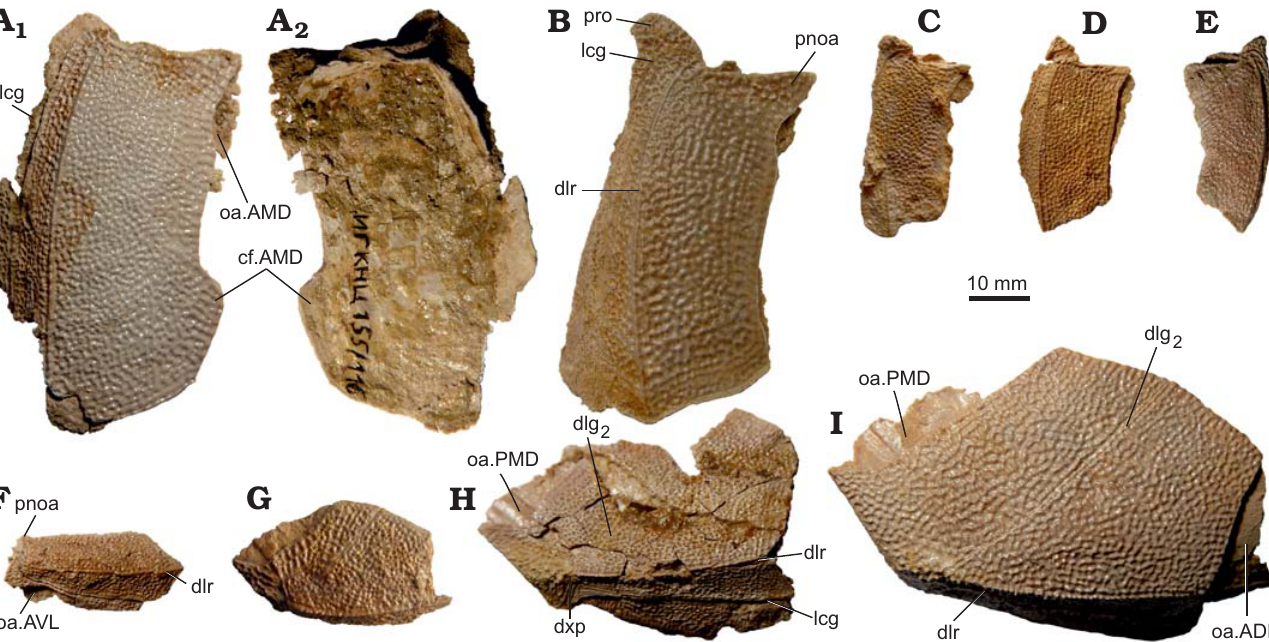
Fig. 10. Antiarchan fish Bothriolepis leptocheira jeremejevi (Rohon, 1900), Sosnogorsk locality, Sosnogorsk Formation, lowermost Famennian, anterior dorso-lateral (A–D, F, left; E, right) and left mixilateral (G–I, right) plates of the trunk armour. A . IG KSC 155/116 in dorsal (A 1 ) and visceral (A 2 ) views. B . IG KSC 155/111. C . IG KSC 155/61. D . IG KSC 155/60. E . IG KSC 155/136. F . IG KSC 155/112. G . IG KSC 155/110. H . Incomplete IG KSC 155/144. I . IG KSC 155/115. B–E, G–I, in dorsal views; F, in lateral view. Abbreviations: ADL, anterior ventro-lateral plate; AMD, anterior median dorsal plate; AVL, anterior ventro-lateral plate; cf.AMD, area overlapping AMD; dlg 2 , posterior oblique dorsal sensory line groove; dlr, dorso-lateral ridge of trunk armour; dxp, dorso-ventral pit-line groove; lcg, main lateral line groove; oa.ADL, oa.AMD, oa.AVL, oa.PMD, area overlapped by ADL, AMD, AVL or PMD respectively; PMD, posterior median dorsal plate; pnoa, postnuchal ornamented corner of ADL; pro, processus obstans of trunk armour.